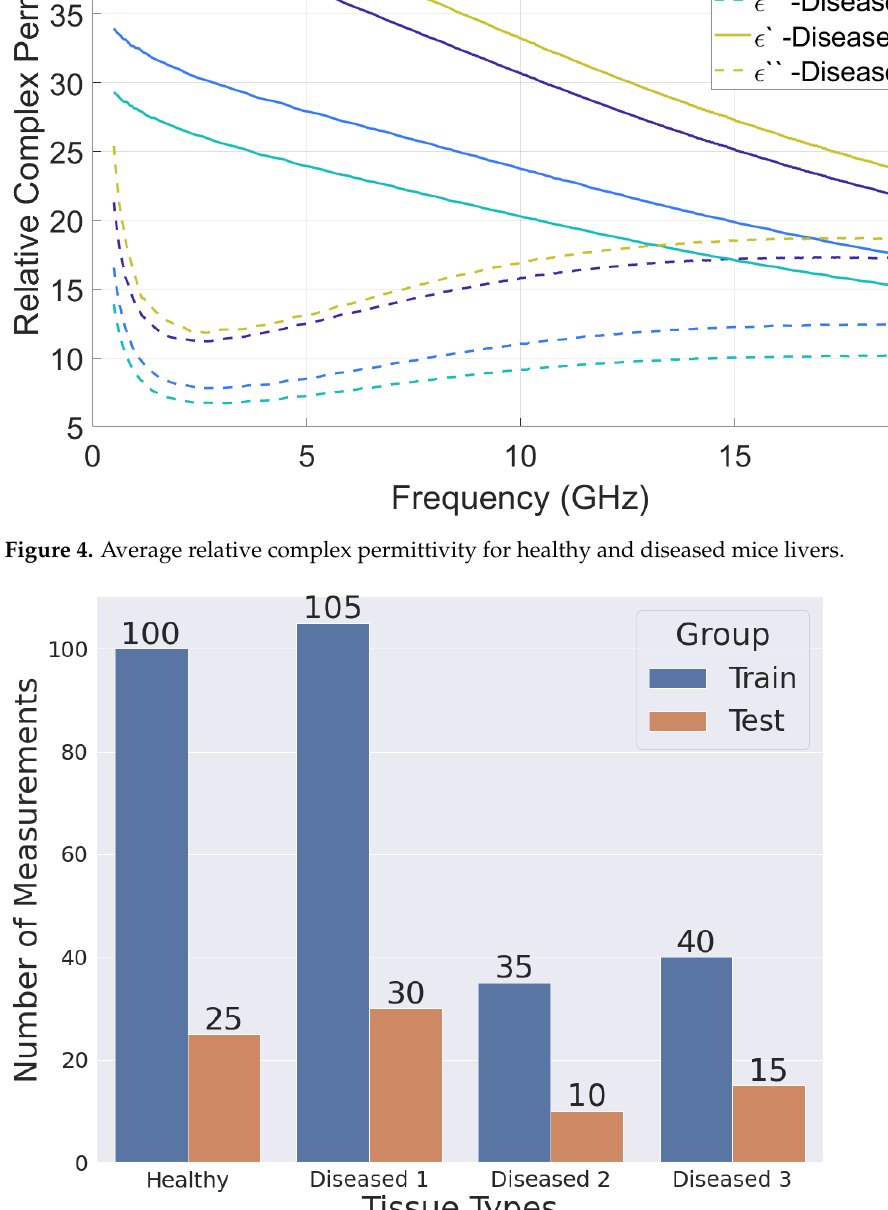
Figure 4. Average relative complex permittivity for healthy and diseased mice livers.